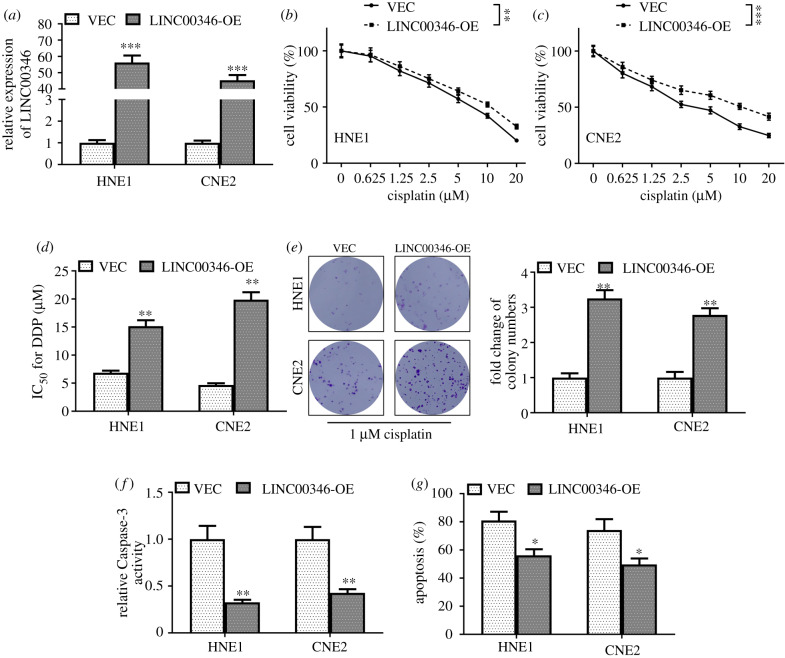
Over-expression of LINC00346 promotes cisplatin resistance of NPC cells. (a) The relative expression of LINC00346 in HNE1 and CNE2 cells transfected with LINC00346 over-expression plasmid (LINC00346-OE) or empty vector plasmid (VEC). (b and c) HNE1 and CNE2 cells transfected LINC00346-OE or VEC were treated with different concentrations of cisplatin for 48 h and analysed by CCK-8 assay. (d) Colony formation assay of HNE1 and CNE2 cells transfected with LINC00346-OE or VEC. (e) HNE1 and CNE2 cells transfected with LINC00346-OE or VEC were treated with cisplatin for 48 h to determine the IC50 of cisplatin. (f,g) Apoptotic rate of HNE1 and CNE2 cells transfected with LINC00346-OE or VEC with the cisplatin treatment (10 µM) was measured by Caspase-3 activity assay and histone/DNA ELISA. The data show the mean ± s.d. *p < 0.05; **p < 0.01; ***p < 0.001.